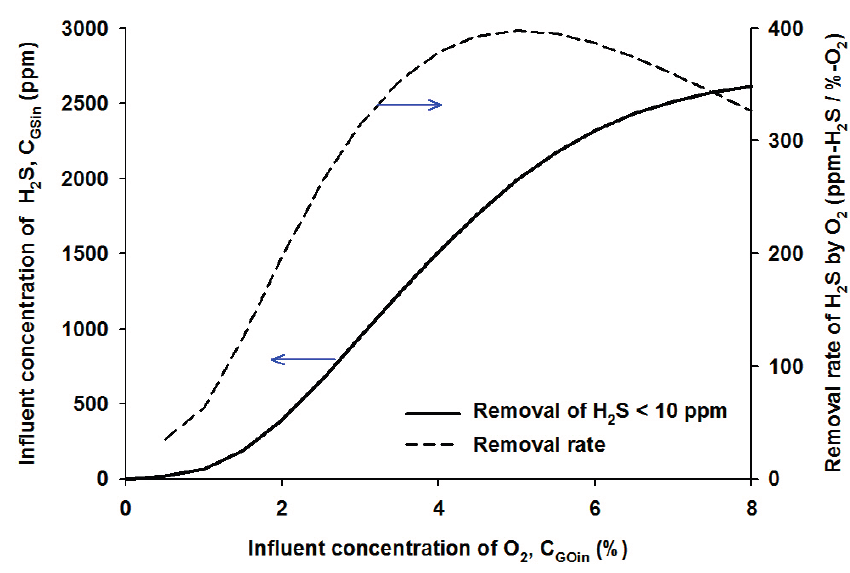
Figure 7. The highest inlet concentration of H 2 S and the specific removal rate of H 2 S as a function of the inlet oxygen